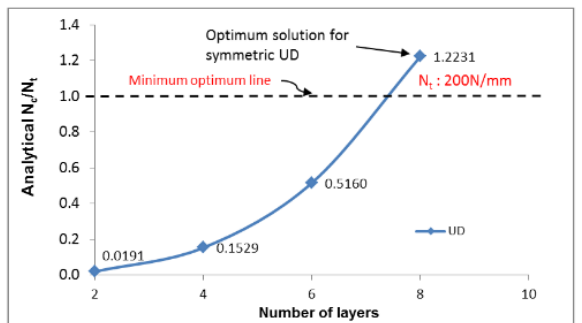
Figure 9: History of progression of critical buckling load for the fittest laminates made of UD plies as the number of plies is in- creased. Set target buckling load is 200N/mm.